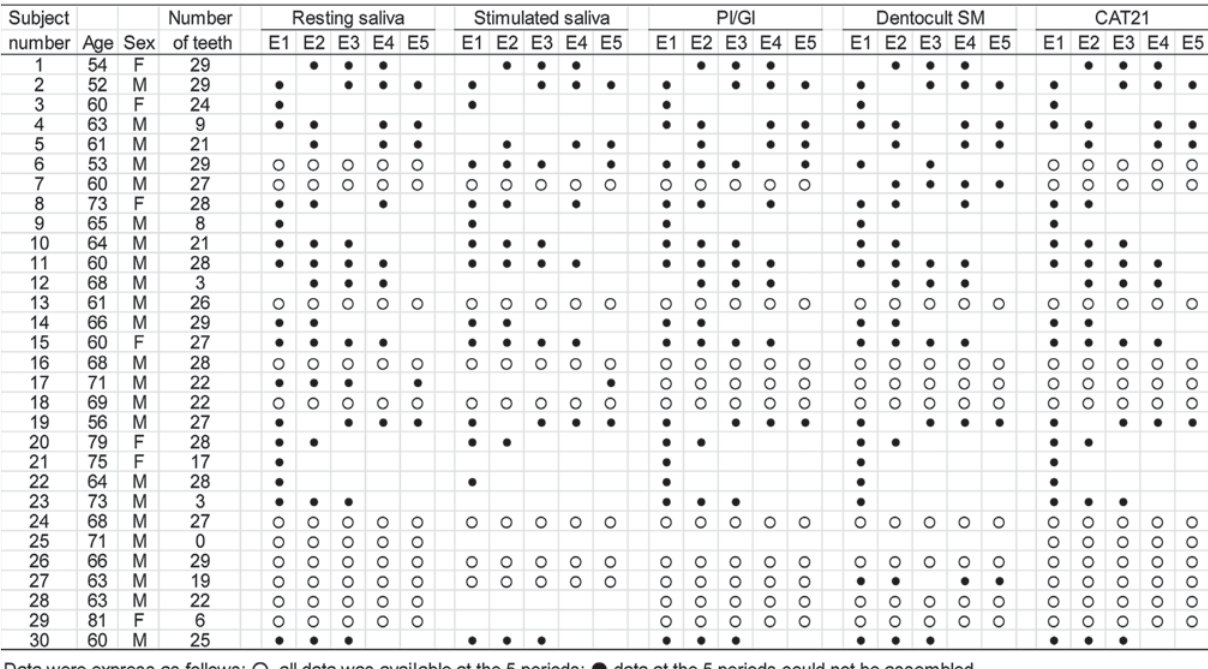
Figure 1- (cid:2)(cid:3)(cid:4)(cid:5)(cid:6)(cid:7)(cid:8)(cid:2)(cid:5)(cid:9)(cid:2)(cid:10)(cid:11)(cid:12)(cid:13)(cid:8)(cid:14)(cid:15)(cid:10)(cid:2)(cid:4)(cid:8)(cid:14)(cid:8)(cid:16)(cid:17)(cid:16)(cid:18)(cid:19)(cid:2)(cid:20)(cid:18)(cid:2)(cid:8)(cid:10)(cid:5)(cid:21)(cid:22)(cid:20)(cid:19)(cid:8)(cid:20)(cid:7)(cid:2)(cid:14)(cid:20)(cid:18)(cid:14)(cid:8)(cid:4)(cid:2)(cid:15)(cid:4)(cid:8)(cid:20)(cid:15)(cid:23)(cid:8)(cid:18)(cid:15)(cid:2)(cid:20)(cid:18)(cid:24)(cid:2)(cid:24)(cid:20)(cid:15)(cid:20)(cid:2)(cid:5)(cid:12)(cid:15)(cid:20)(cid:16)(cid:18)(cid:8)(cid:24)(cid:2)(cid:16)(cid:18)(cid:2)(cid:8)(cid:20)(cid:14)(cid:22)(cid:2)(cid:8)(cid:25)(cid:20)(cid:23)(cid:16)(cid:18)(cid:20)(cid:15)(cid:16)(cid:5)(cid:18)(cid:2)(cid:21)(cid:8)(cid:4)(cid:16)(cid:5)(cid:24)(cid:10)